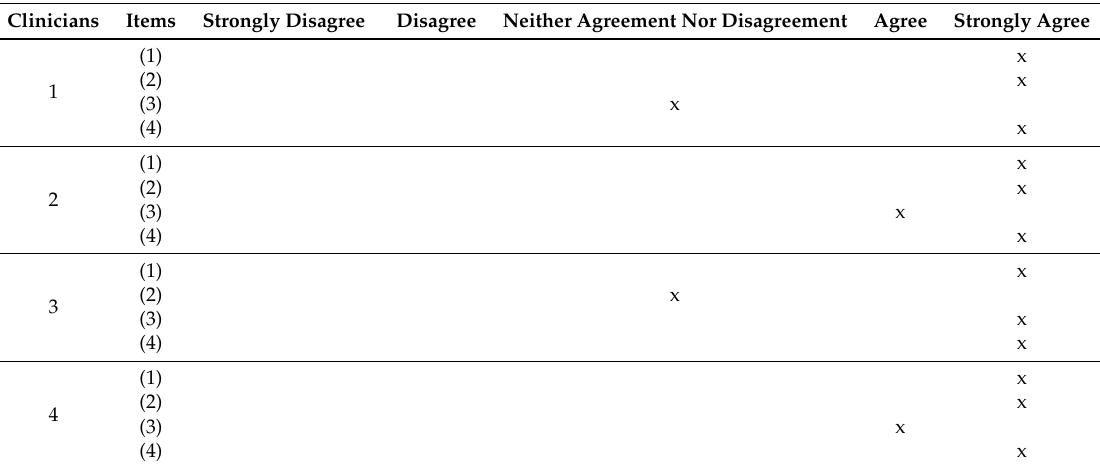
Table 4. Results of satisfaction